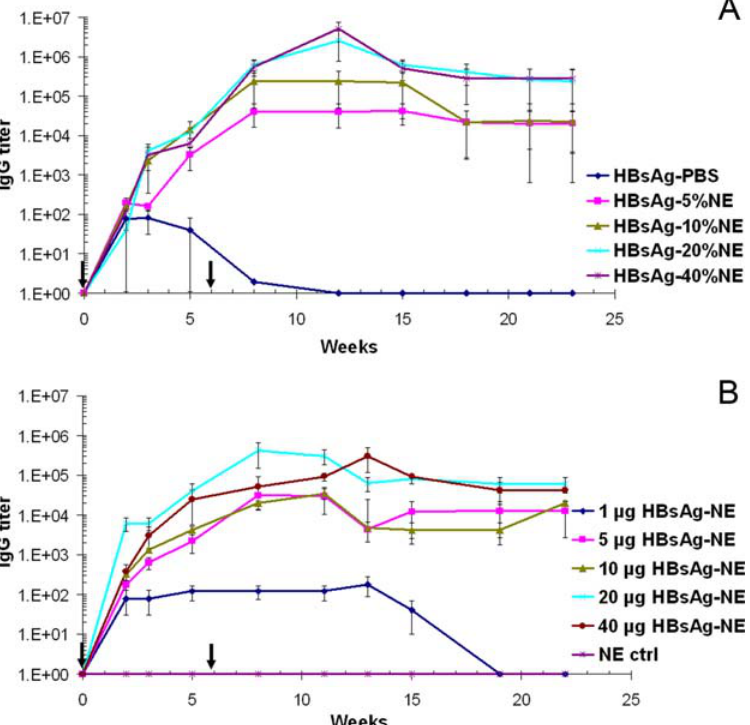
Figure 3. Development of IgG response in serum. Effect of NE adjuvant: Mice were immunized intranasally with HBsAg-NE consisting of 20 m g of HBsAg mixed with 0% to 40% concentrations of NE (A). Significant statistical difference with p value , 0.05 was observed between all HBsAg- NE formulations and HBsAg-PBS vaccine. Antigen dose escalation: Mice were immunized intranasally with 1 m g to 40 m g HBsAg mixed with 20% NE (B). A significant statistical difference with p value , 0.05 was observed between all 5 m g to 40 m g HBsAg-NE formulations and 1 m g HBsAg-NE vaccine. Serum anti-HBsAg IgG antibody concentrations are presented as mean of endpoint titers in individual sera + / 2 SEM. * indicates a statistical difference ( p value , 0.05 ) in the anti-HBsAg IgG titers. Arrows indicate vaccine